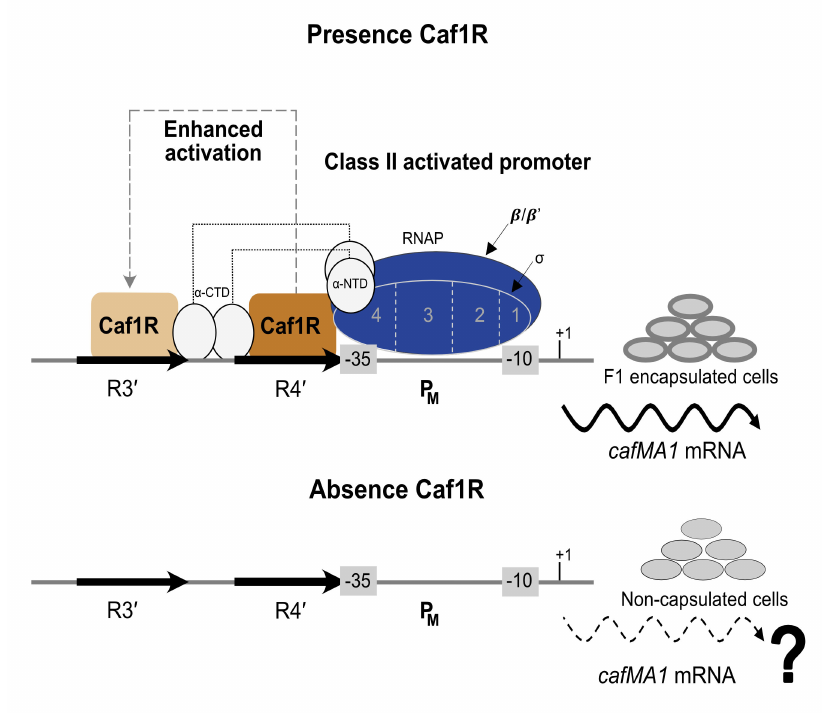
Figure 6. Model of Caf1R-dependent transcription activation at P M promoter of the caf locus. Based on published evidence of RNA polymerase (RNAP)-regulator interactions, it is proposed that Caf1R either initially interacts with RNAP and then binds at the R4 (cid:48) caf DNA motif or first binds to the R4 (cid:48) caf DNA motif and then interacts with RNAP to enhance RNAP-Caf1R interaction at the P M promoter for initiating transcription of the cafMA1 operon. In addition, to this Class II activation on binding at P M , the diagram also depicts the possibility of further activation of transcription, in a Class I manner, via binding of Caf1R at the R3 (cid:48) caf DNA repeat motif. Expression of cafMA1 leads to abundant F1 level on the cell surface, giving the appearance of encapsulated cells. In the absence of Caf1R there is little or no expression of cafMA1